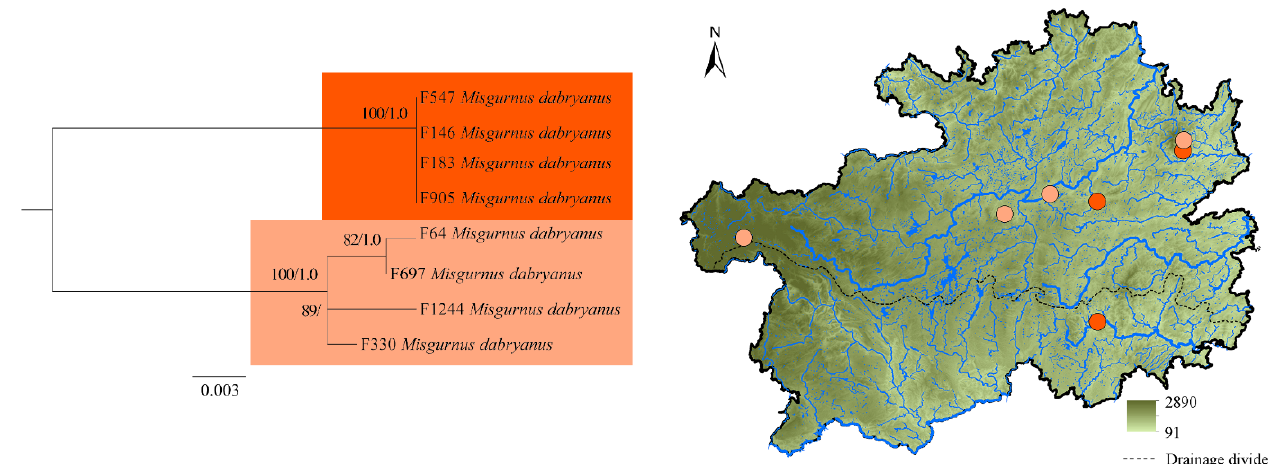
Figure 6. Phylogenetic tree showed cryptic diversity of Misgurnus dabryanus and collection locations. Results for BI analysis were mapped onto the ML tree. Numbers on the branches are bootstrap per- centages (%) from ML and posterior probability from BI. ML with bootstrap >50% and BI with PP >0.5 were shown. The scale bar indicates the number of substitutions per site.